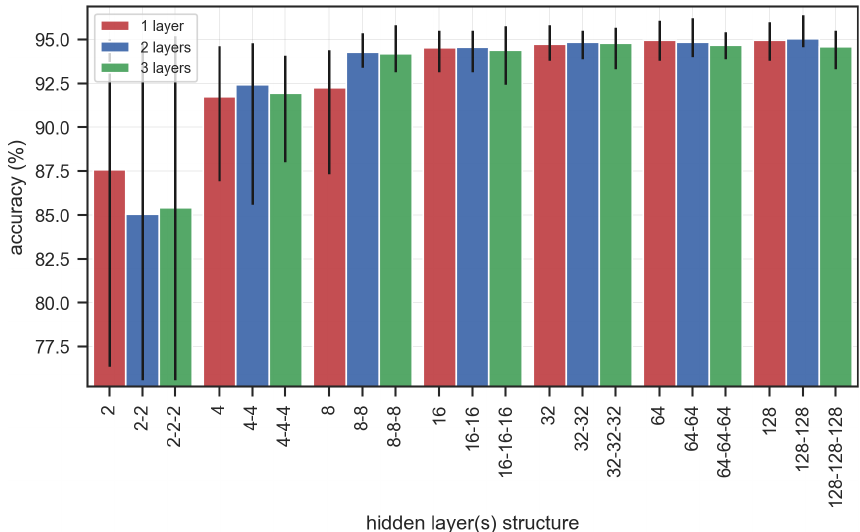
Figure 6. Accuracy of classification prediction for the calibration cases using different architectures of the classification ANN with a different number of hidden layers and neurons per layer. On the x axis the architecture of each ANN is represented by the number of neurons per layer, with layers separated by “–”. The bars indicate the mean accuracy values between the 10 randomizations of the benchmark dataset, and the lines show the min and max values.